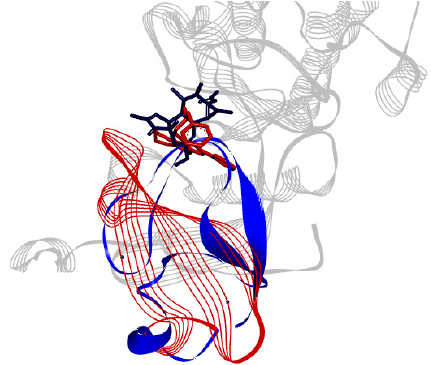
Figure 5. Alignment of tertiary structure of the catalytic binding sites for PKC δ (blue) and PKC ι (red).